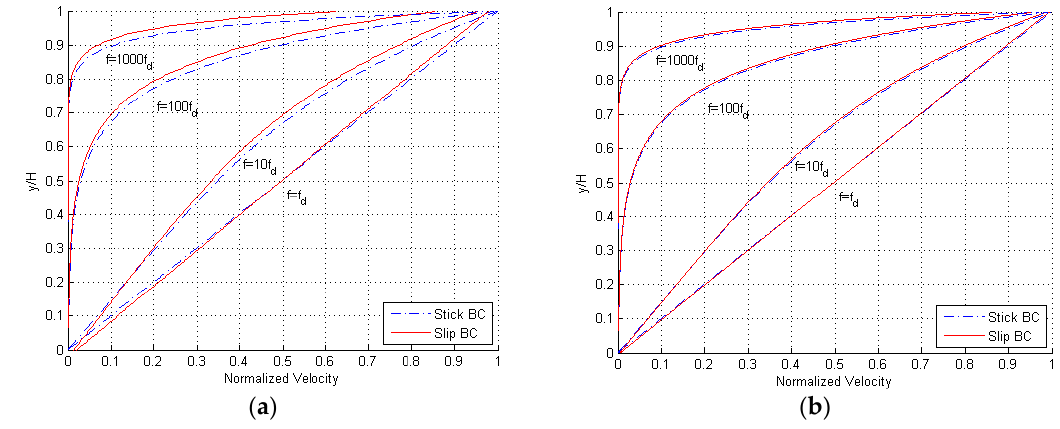
profile at varying frequency 𝑓 of oscillation of the moving plate at 𝑦 = 𝐻 , for both stick and slip BCs. Figure 5. Engaged solution, ( a ) H = 3 µ m and ( b ) H = 12 µ m: maximum amplitude of the velocity